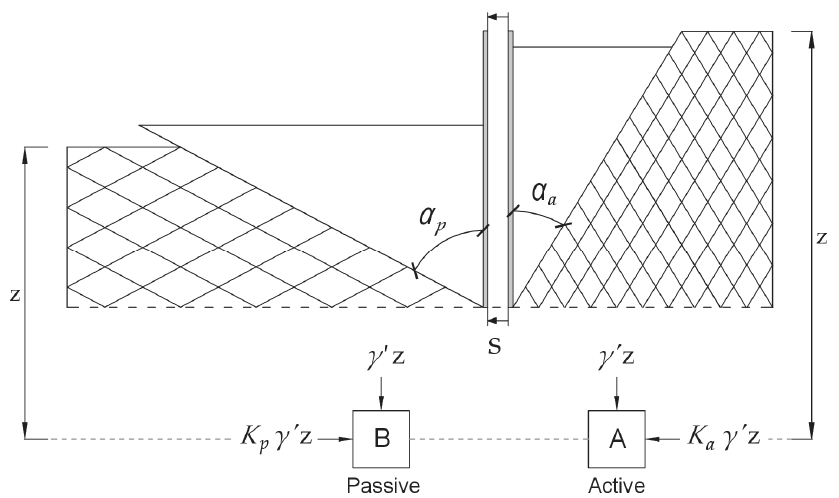
Figure 1. The active and passive sides of the wall along Rankine zones (courtesy of Sigurdur Mar Valsson [24]).